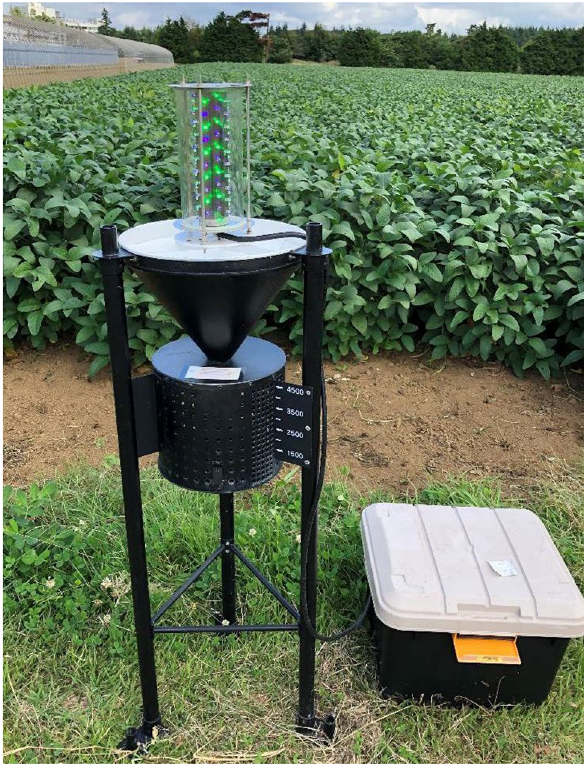
Figure 4. Photograph of combined UV and green LED trap used in the experiments.